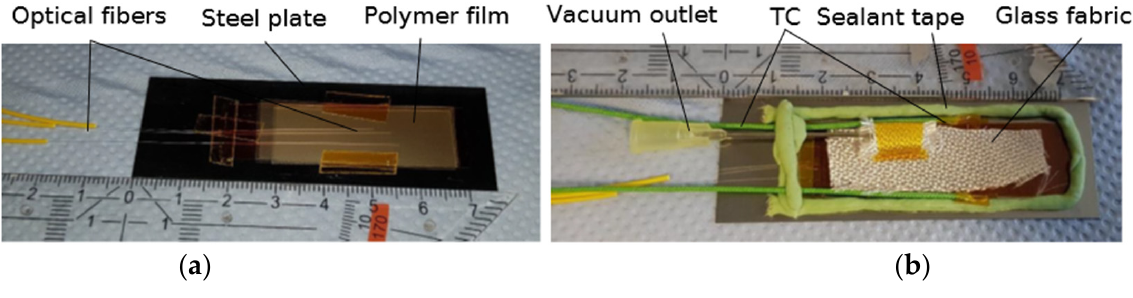
Figure 3. Stages of vacuum bagging setup with the films and the prepared optical fibers ( a ) and before sealing the setup with a PI film ( b ).